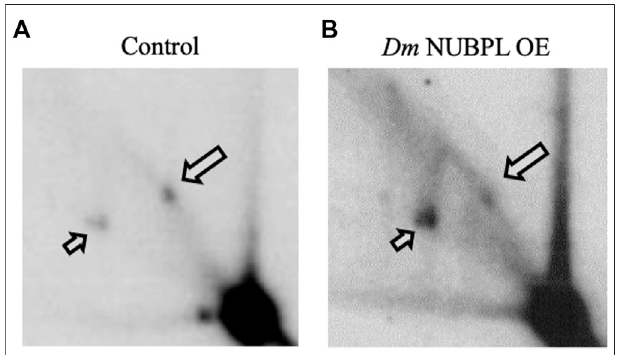
FIGURE 6 | Overexpression of NUBPL alleviates mtDNA replication pausing. 2DAGE of ClaI-treated mtNA isolated from control S2 cells (i) or HA- NUBPL-overexpressingS2cells (ii) hybridizedwithprobe6(see Materialsand Methods for details). Bold arrows indicate discrete spots on Y arcs that represent the major replication pause site at slow zone 2 (see also (Joers and Jacobs, 2013; Ciesielski et al., 2018)). Thin arrows indicate fully replicated fragment